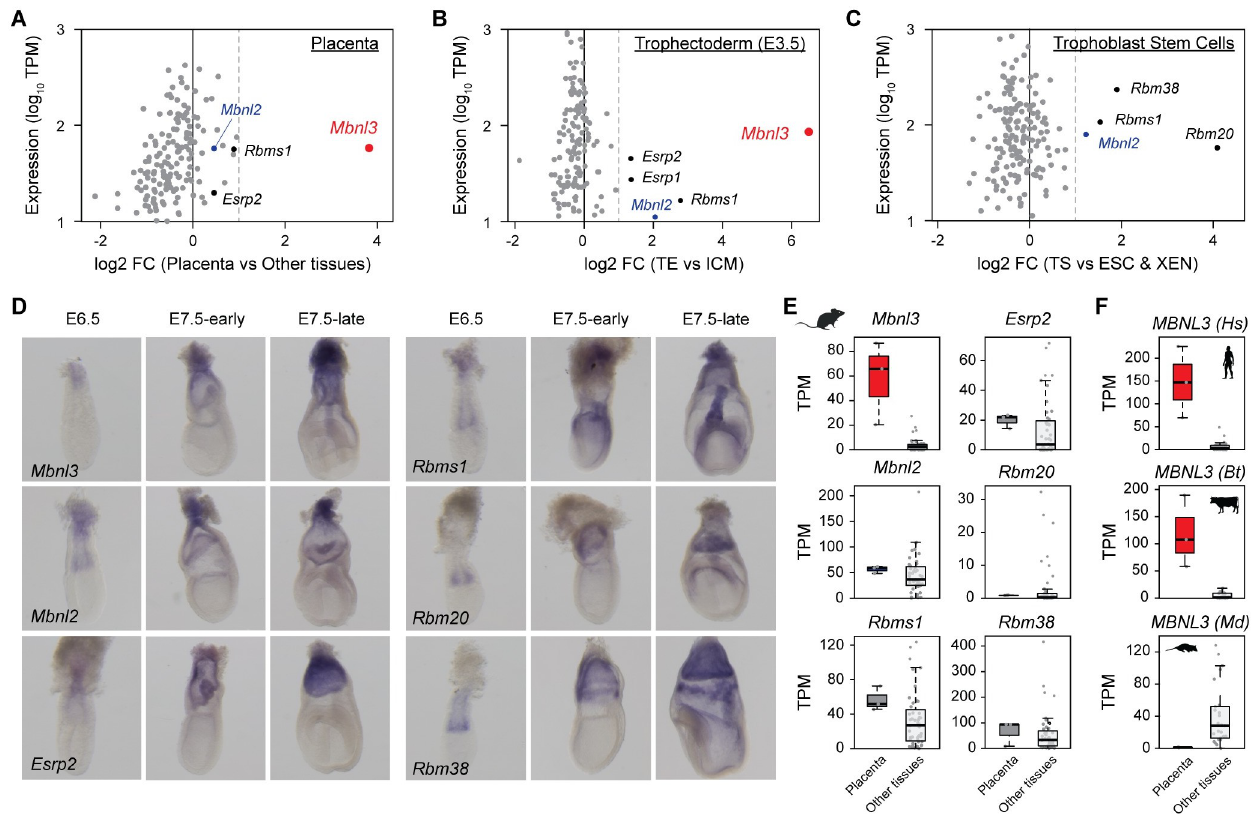
Fig 1. Analysis of splicing factor expression enrichment in trophoblastic versus nontrophoblastic tissues. (A–C) Scatter plots showing trophoblastic expression level and enrichment for 197 splicing regulators in 3 separate comparisons of trophoblastic versus nontrophoblastic tissues. (D) Whole-mount in situ hybridisation analysis of the expression of splicing regulators found to be enriched in trophoblastic tissues (A–C) in mouse embryos at the indicated stages. (E, F) Box plots showing expression levels of the indicated splicing factors in placenta and nonplacental tissues in mouse (E) and in human (Hs), cow (Bt), and opossum (Md) (F). The numerical data underlying this figure can be found in S1 Data. ESC, embryonic stem cell; ICM, inner cell mass; TE, trophectoderm; TPM, transcript per million; TS, trophoblast stem; XEN, extraembryonic